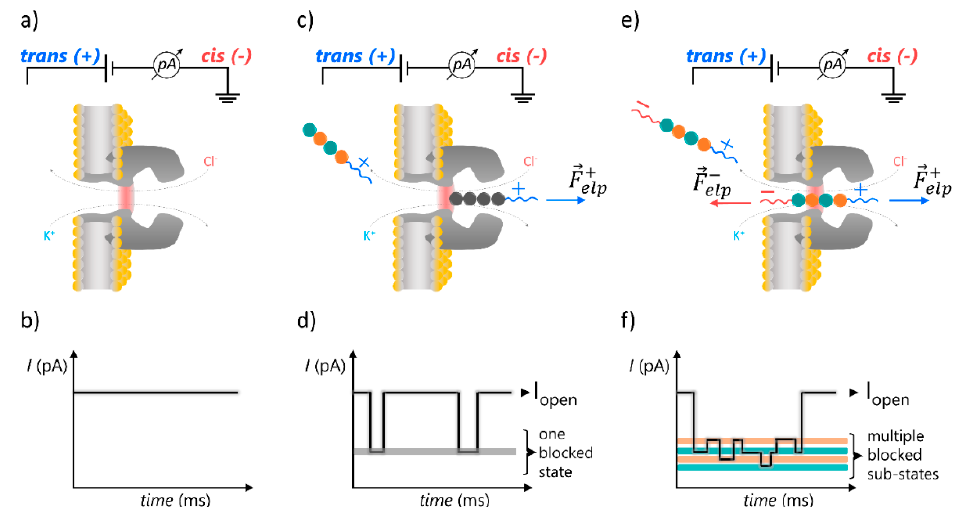
Figure 1. Simplified representation of the nanopore-tweezer technique, aimed at the primary structure characterization of individual PNAs. ( a ) In the absence of non-specific interactions, the ionic current through a single α -hemolysin protein ( α -HL) nanopore isolated in a lipid membrane clamped at a constant potential difference ( ∆ V) remains constant ( b ). ( c ) Capture of an electrically charged analyte with the nanopore and its journey across the nanopore are seen as reversible changes of the ionic current through the nanopore between the open state (I open —free nanopore) and the blocked state (I blocked —nanopore transiently occupied by the analyte) ( d ). ( e ) If the PNA is decorated with oppositely charged segments at its ends, turning it into a macro-dipole during the capture events inside the voltage-biased nanopore, an electrostatic tug-of-war between opposite electric forces exerted at the sides of the analyte ensues, increasing the residence time of the analyte inside the nanopore. This allows for the visualization of characteristic ionic current fluctuations through the nanopore ( f ), whose features may correlate with the PNA’s primary structure.